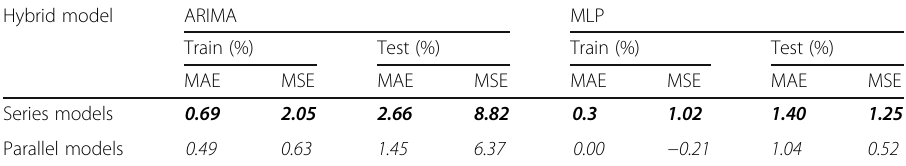
Table 7 Average improvement in series and parallel models over ARIMA and MLP models for S&P 500 Hybrid